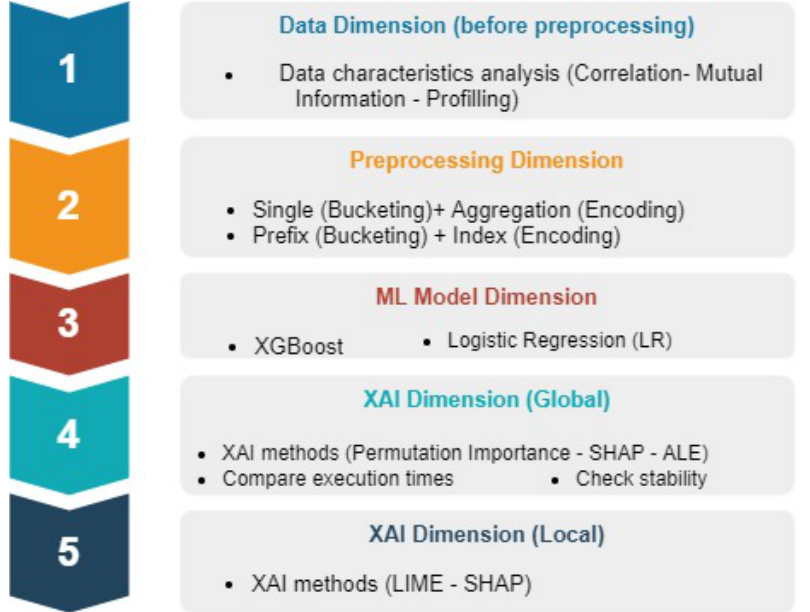
Figure 2. XAI Comparison Framework